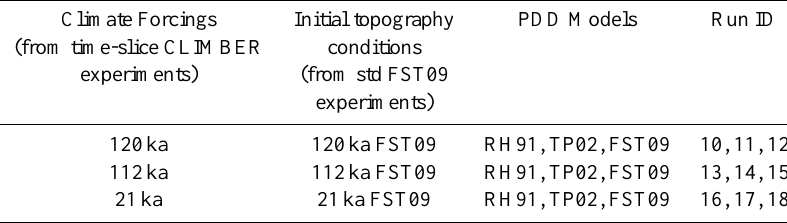
Table 2b. GRISLI equilibrium simulations: past